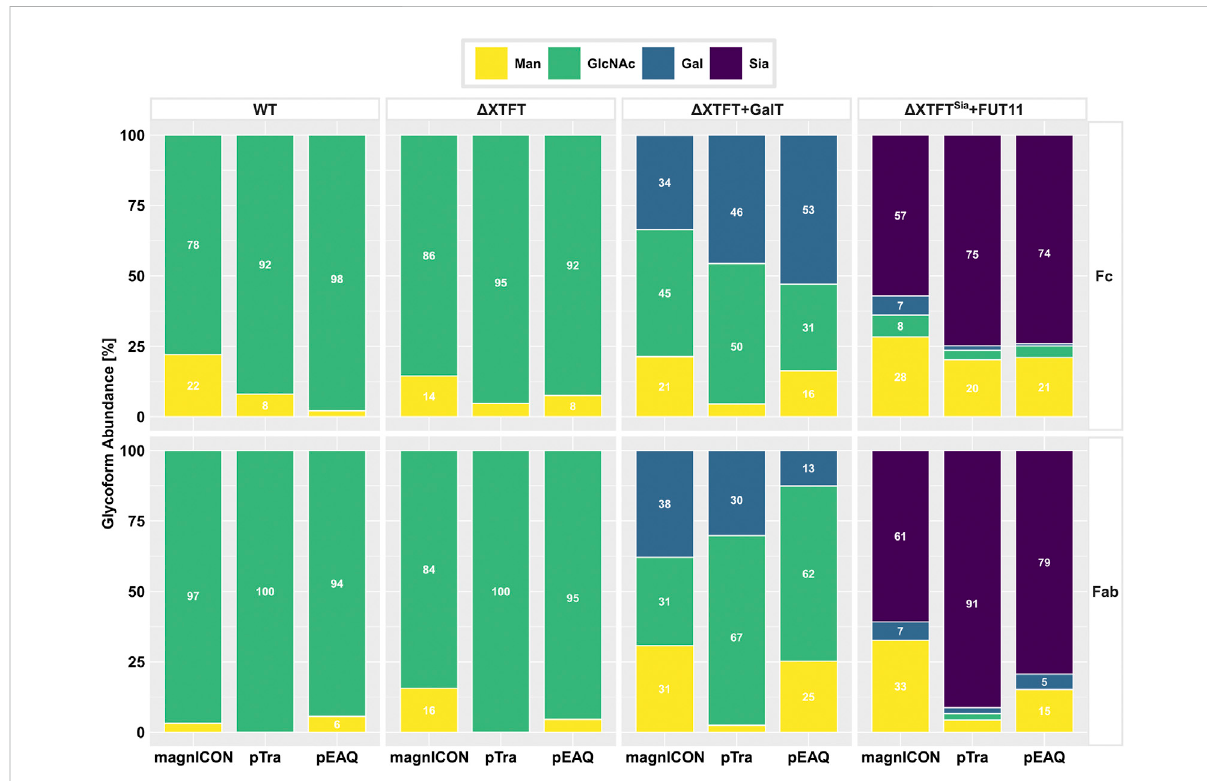
FIGURE 3 MS-basedanalysesofN-glycosylationofCxproduced bymagnICON,pTraandpEAQusing N.benthamiana WT(WT),RNAiline Δ XTFT( Δ XTFT), Δ XTFTco-in fi ltratedwithhuman GalT ( Δ XTFT+GalT)and Δ XTFT Sia (transgenic Δ XTFT,stablytransformedwithhumansialylationpathway)and FUT11 co-in fi ltration ( Δ XTFT Sia + FUT11). Glycans are grouped as follows: yellow: mannosidic structures; green: GlcNAc terminating N-glycans; blue: galactosylated N-glycans; purple: sialylated N-glycans. Bars represent the relative abundance (%) of glycoforms present at the Fc and the Fab domain, respectively (for detailed information, see also Supplmentary Figure S2). Abundances ≥ 5% are displayed as rounded whole